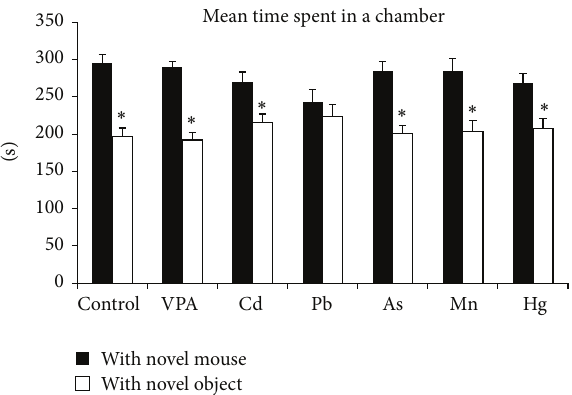
Figure 3: Three-chambered testing apparatus for social interaction: mice from all groups except the Pb exposed group exhibited a normal preference to spend significantly more time with a novel stranger mouse rather than with a novel object. Data were analyzed with a 2-tailed paired 𝑡 -test for each treatment group. The preference was statistically significant in all groups ( 0.002 < 𝑝 < 0.04 range), but Pb treated group ( 𝑝 > 0.05 ). ∗ denotes statistical